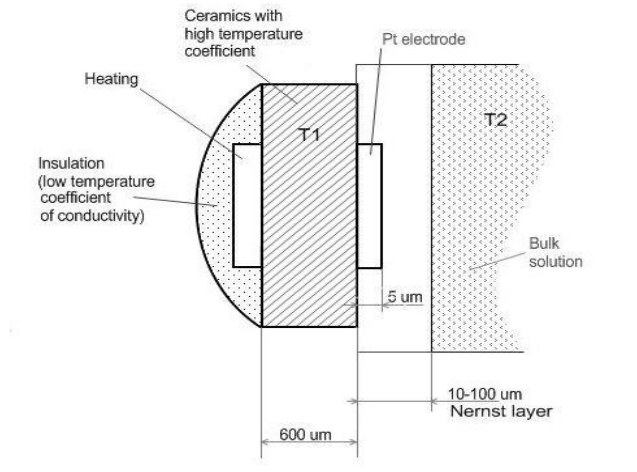
Figure 1. Schematics of temperature gradient application on planar electrode realized on ceramics and immersed in the solution